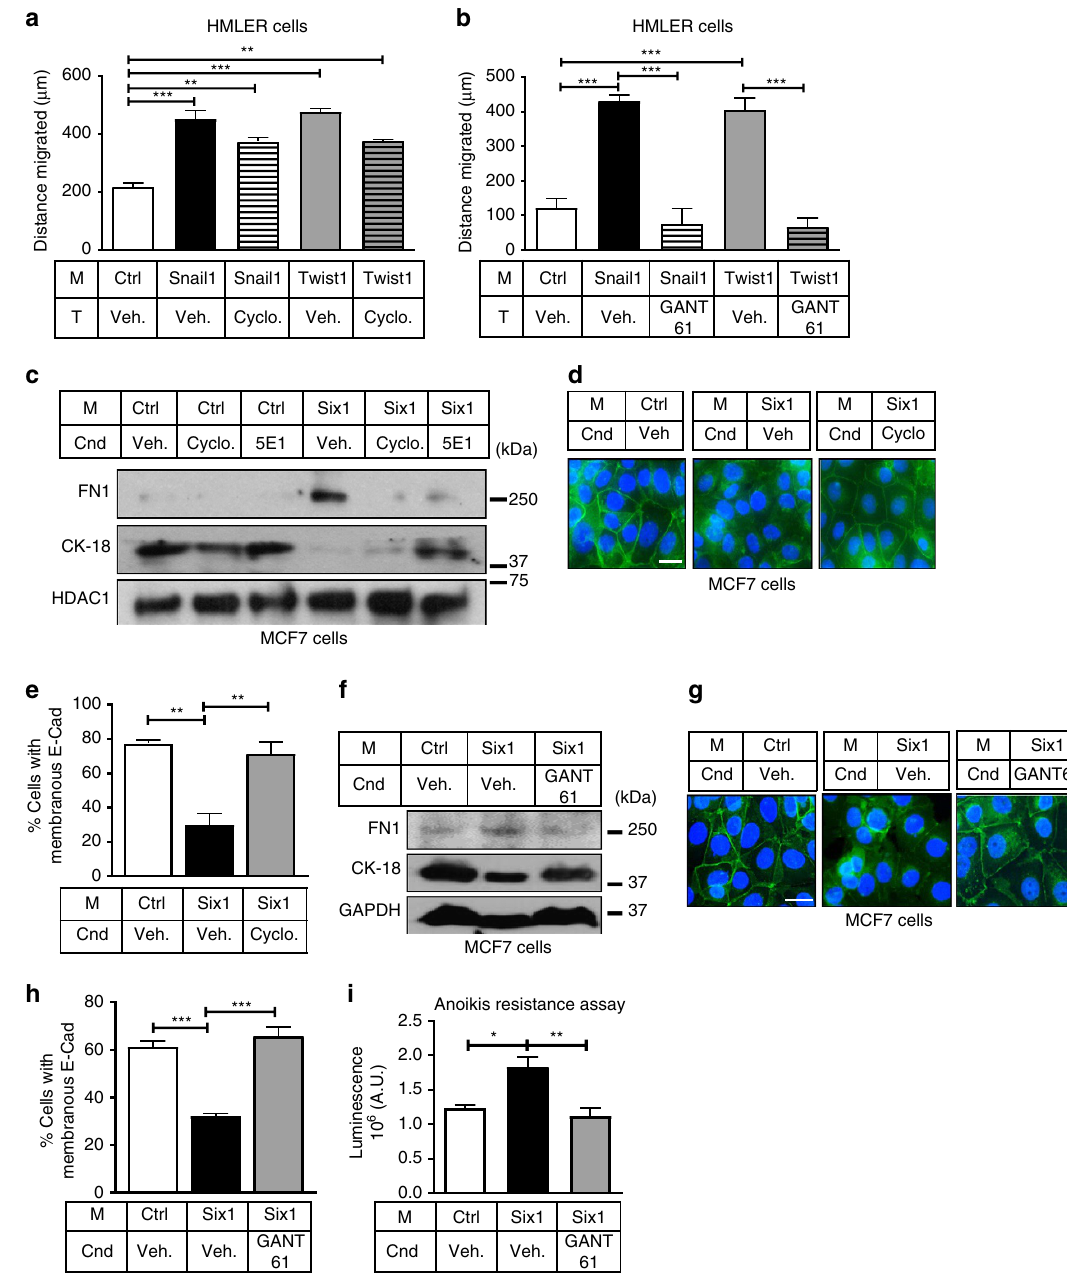
Figure 5 | NCA activation of GLI is central downstream of EMT-TFs to alter phenotypes. ( a , b ) Seven hour migration assays of HMLER-Ctrl cells cultured in HMLER-Snail1/Twist1 CM treated with ( a ) cyclopamine (Cyclo.) or ( b ) GANT61 or corresponding vehicle (Veh.) control. ( c , f ) Western blot analyses of WCLs from MCF7-Ctrl cells cultured in MCF7-Ctrl/Six1 CM for 48h ± indicated inhibitors. HDAC1, GAPDH, loading controls. ( d , g ) Representative ICC of E-Cad (green) in MCF7-Ctrl cells cultured in MCF7-Ctrl/Six1 CM for 48h ± indicated inhibitors. Scale bar, 20 m m; DAPI, blue ( e , h ) Quantification of % membranous E-Cad in d , g . Counts performed on Z 45–60 cells per condition. ( i ) Anoikis resistance assay in MCF7-Ctrl cells in indicated CM ± GANT61 for 24h. Cnd, Condition; M, Media; T, Treatment; s.e.m. shown, n Z 3, one-way ANOVA with Tukey’s post test in all cases. * P o 0.05, ** P o 0.01 and *** P o